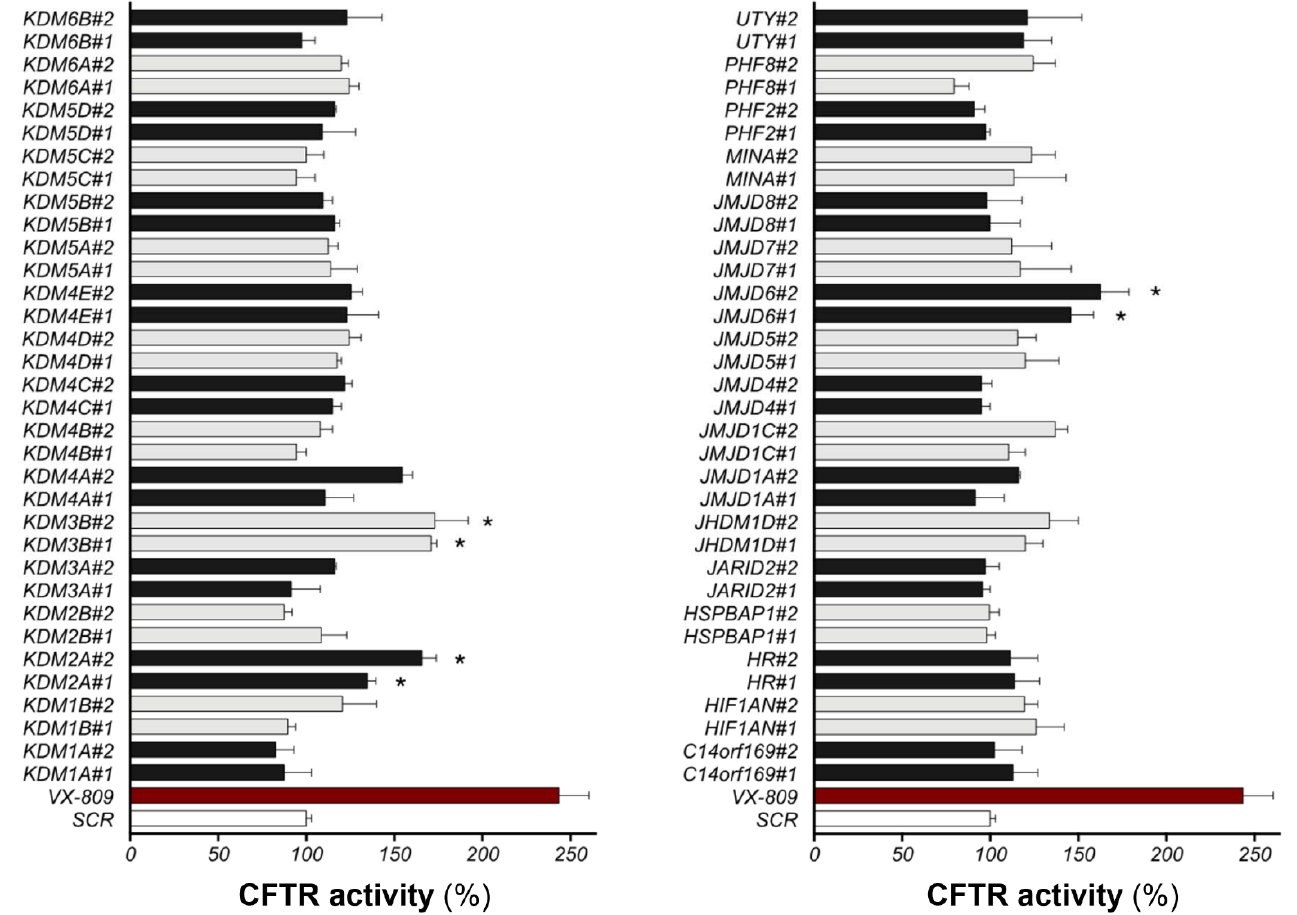
Figure 1. SiRNA screening against all human demethylases. CFBE41o- stably overexpressing F508del-CFTR and HS-YFP were transfected for 48 h with two different siRNAs for each target or with scrambled siRNAs. The panel indicates the CFTR activity as a percentage of control (SCR) (scrambled-siRNAs + DMSO) (mean ± SD, n = 8; * p < 0.05 vs. SCR). The extent of rescue obtained with 3 μM VX -809 is indicated by a red bar for comparison.